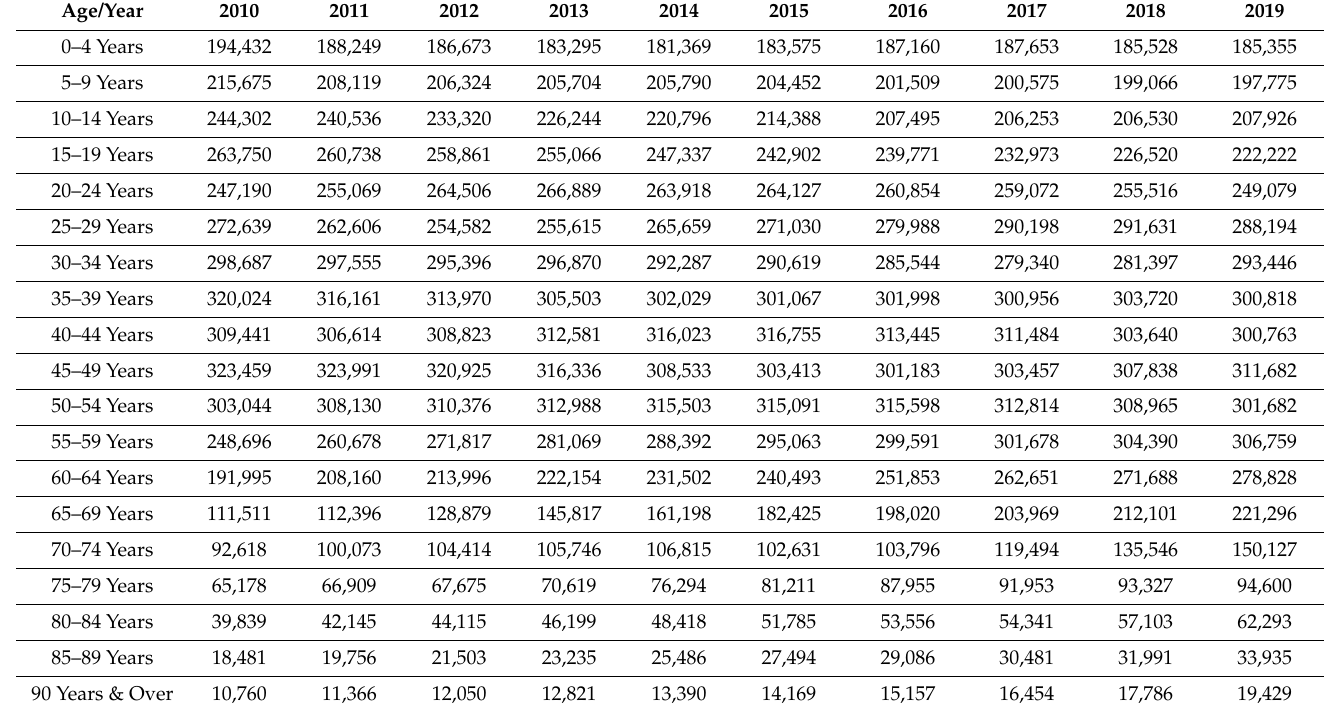
Table 2. Singapore Residents by Age Group: 2010 to 2019.